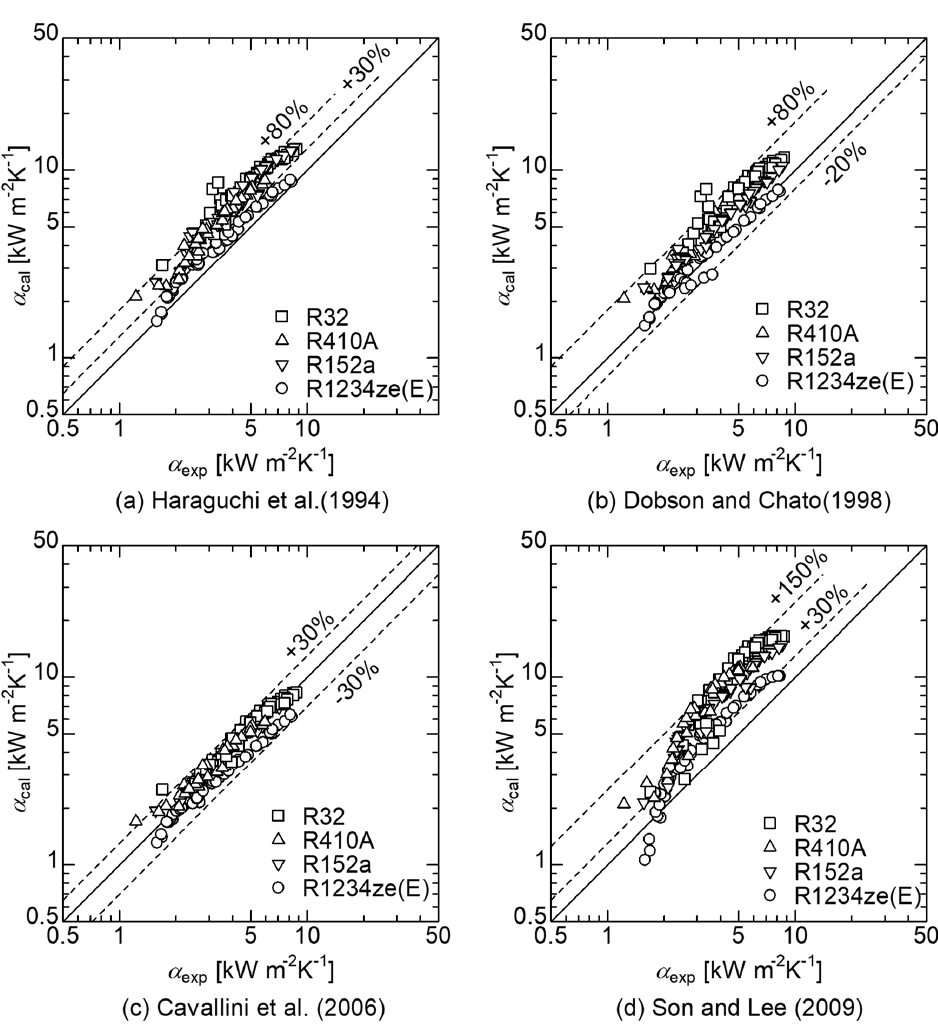
Figure 6. Comparison of measured and predicted heat transfer coefficient values.